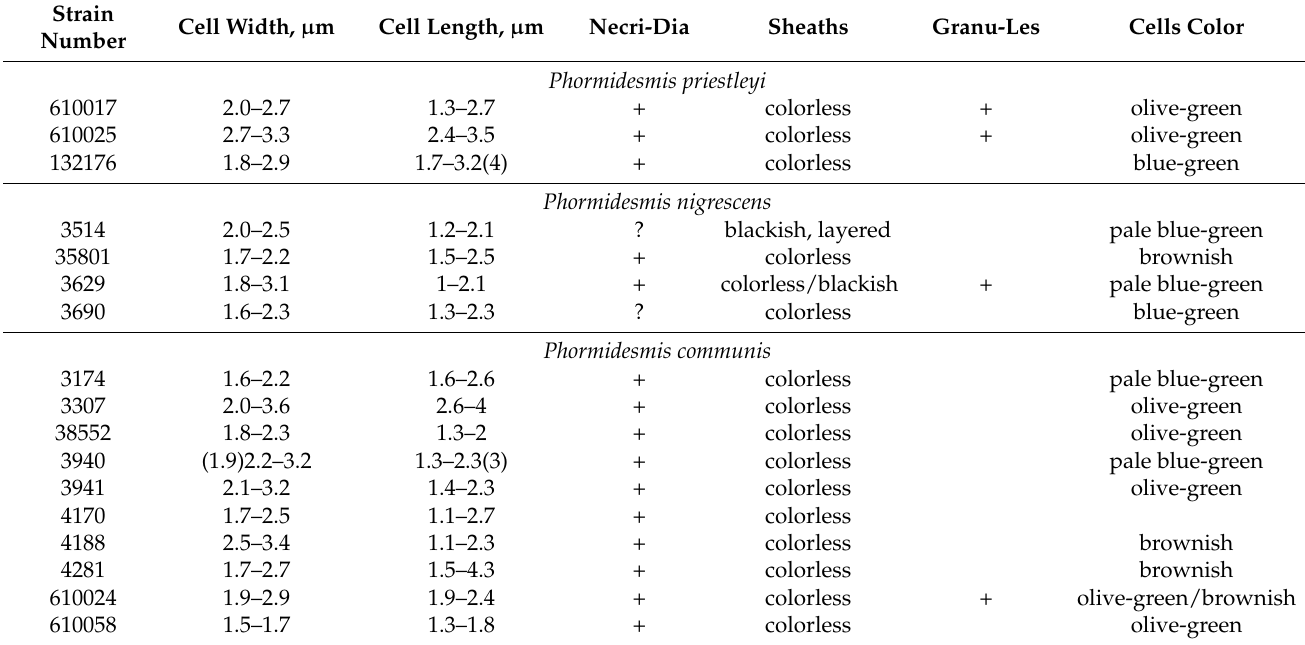
Table 3. Morphological traits of Phormidesmis , and Apatinema